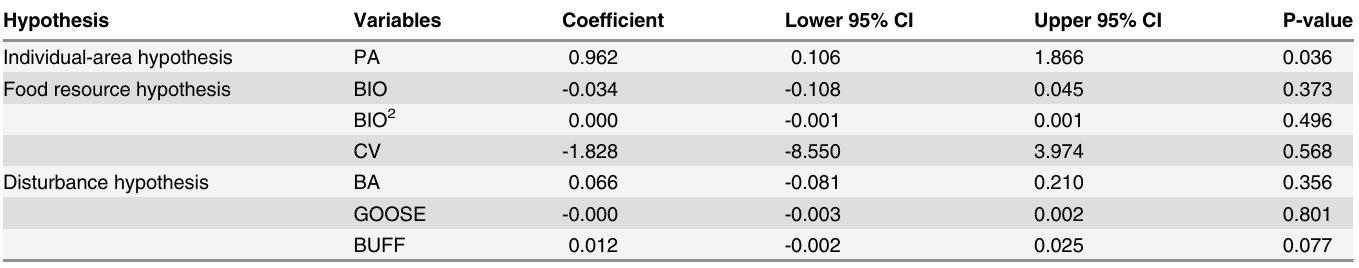
Table 3. Summary of the effects of dependent variables on bean goose density as generated by the MCMCglmm model for each of the hypotheses and independent variables, with coefficients and p-values.